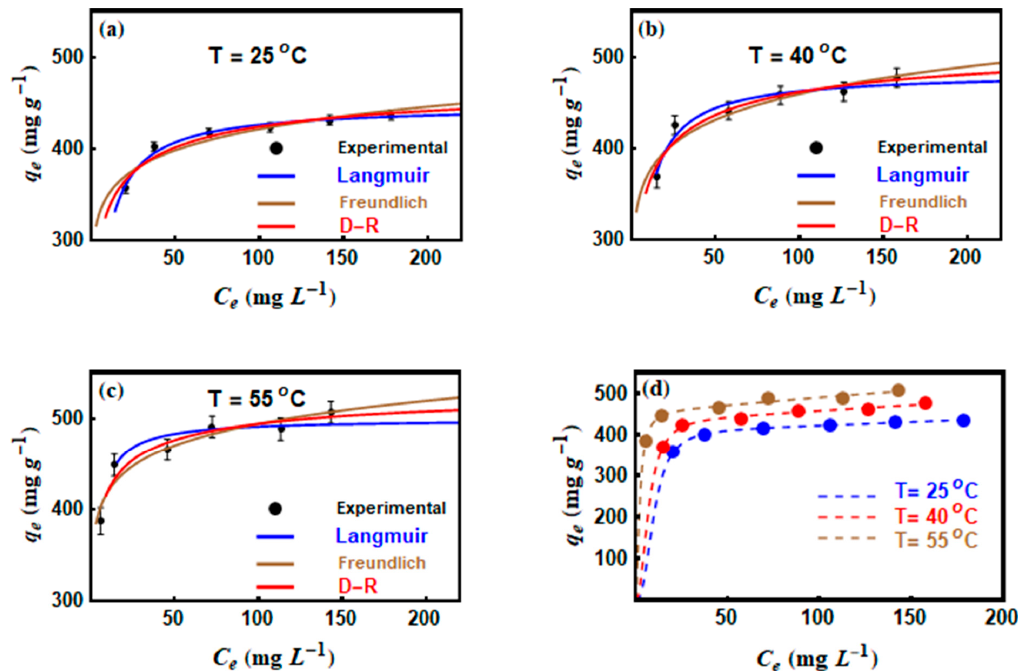
Figure 6. Results of ( a – c ) Langmuir, Freundlich and D-R isotherms and ( d ) statistical physics